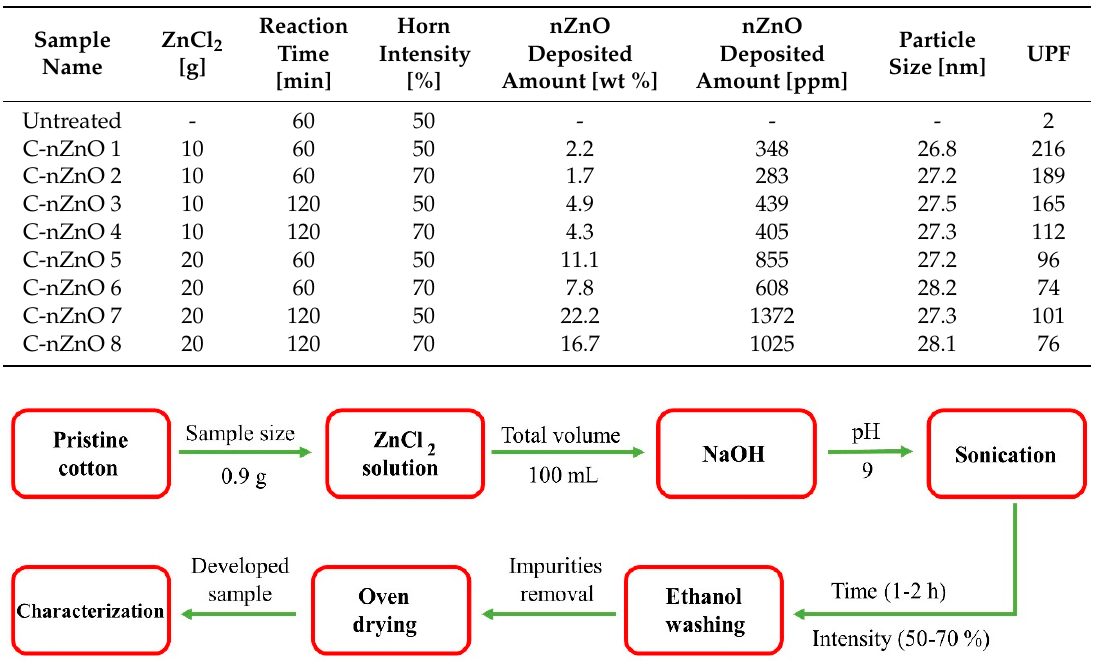
Table 1. Experimental detail and results of developed C-nZnO composites.